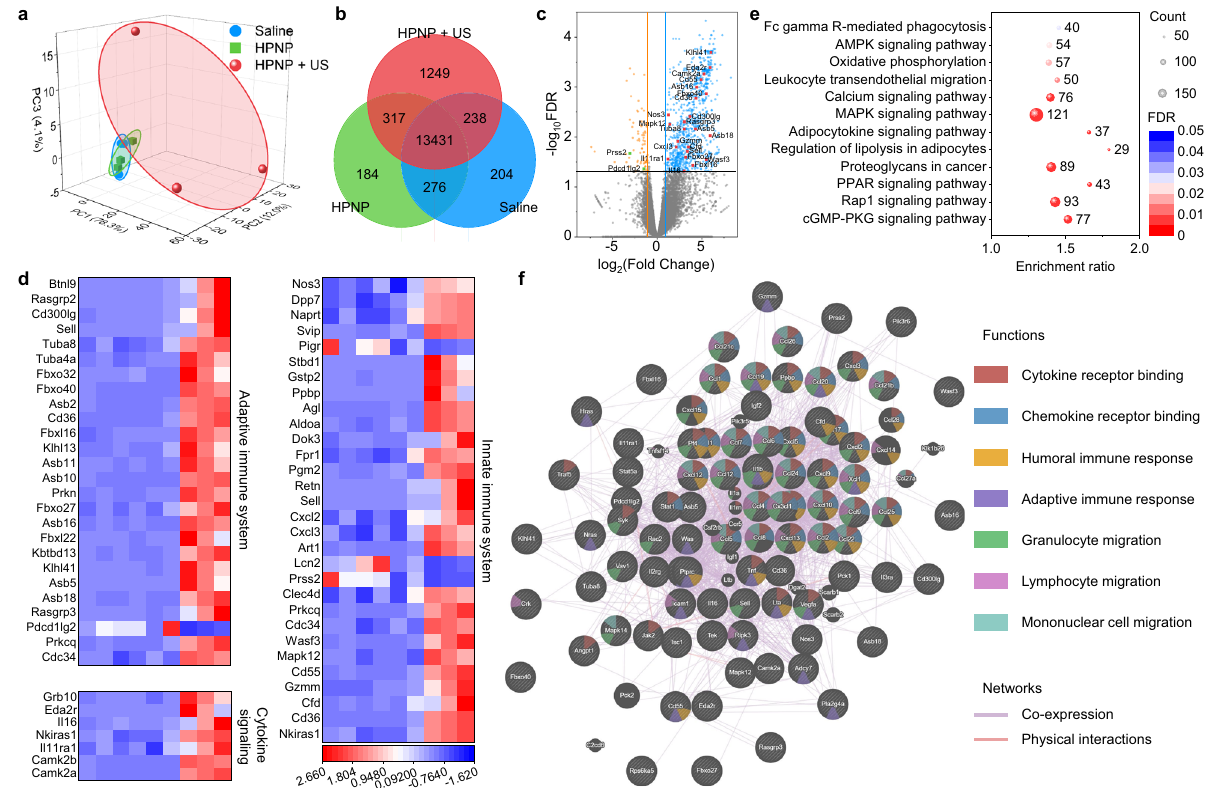
Cdc34PrkcqPdcd1lg2Rasgrp3Asb18Asb5Klhl41Kbtbd13 Fig. 6 Transcriptome analysis of nano-immunocomplex-mediated sono-metabolic checkpoint trimodal cancer therapy. a Principal component analysis (PCA) score plot of the expressed genes in TME of saline-injected, HPNP-injected, or HPNP-injected and sono-irradiated mice ( n = 3). b Venn diagram of the identi fi ed differentially expressed genes. c Volcano plot showing 938 differentially expressed genes (26703 total genes) in TME from HPNP-injected and sono-irradiated mice compared to TME from saline-injected mice. 866 upregulated genes and 72 downregulated genes were differentially expressed in TME in HPNP-injected and sono-irradiated mice. d Expression of selected genes related to the adaptive immune system, cytokine signaling, and innate immune system in TME from HPNP-injected and sono-irradiated mice compared to TME from saline-injected mice. e KEGG enrichment analysis of the identi fi ed differentially expressed genes for studying the pathways of immune responses. f GeneMANIA analysis for predicting gene interactions between differential genes in the immunological processes. Source data are provided as a Source Data fi algorithm, was performed 42 (Fig. 6f). The complex gene networks